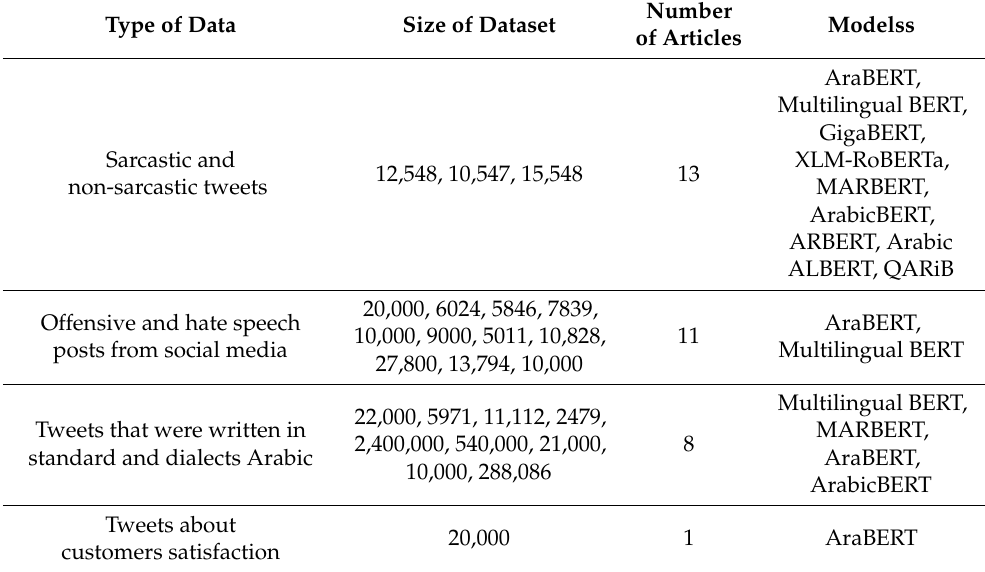
Table 6. Datasets that were used to evaluate the models.